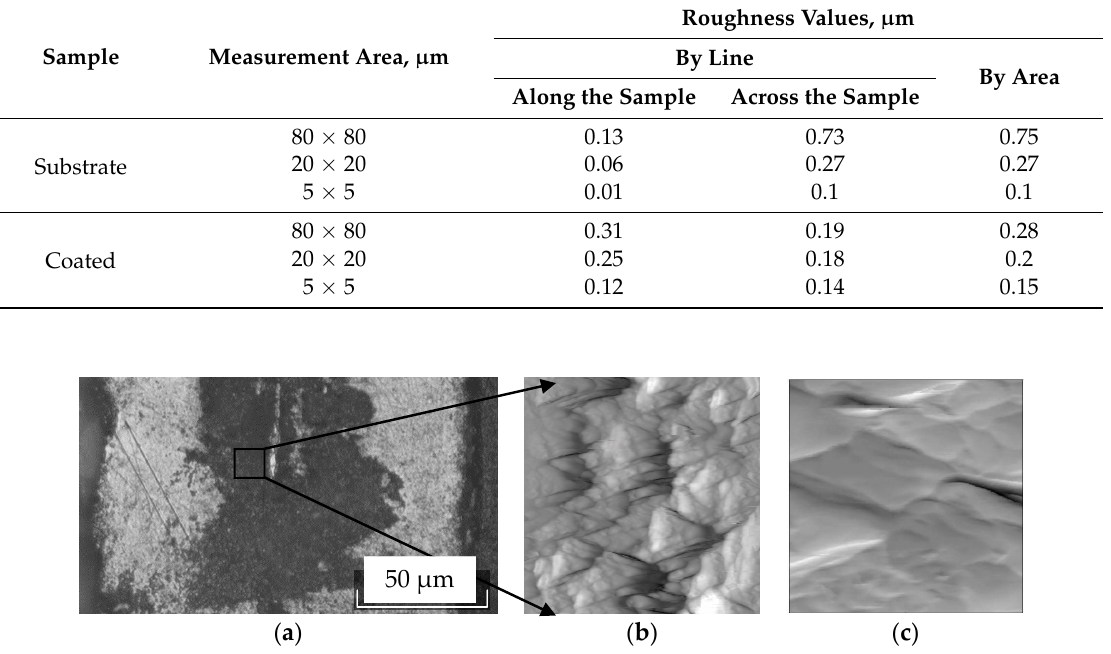
Table 1. Roughness values obtained using an atomic force microscope (AFM).